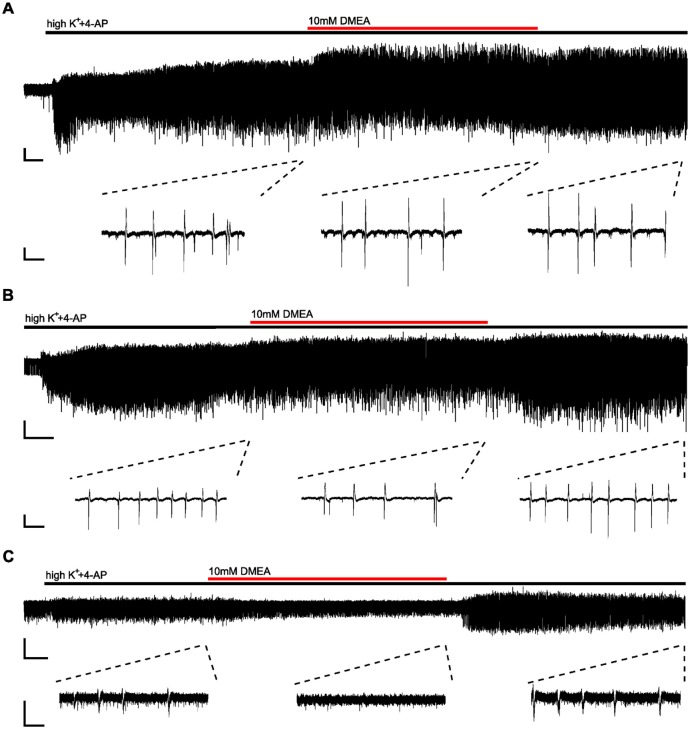
Effects of DMEA on epileptiform activity in human brain tissue ex vivo. Example traces displaying variability of DMEA effects on burst activity; full recordings (top) and excerpts (bottom) from the end of each period (baseline, DMEA and wash-out) demonstrate different effects of DMEA including a lack of response (A, patient 8), a partial block (B, patient 7) and a full block (C, patient 11). Scale bars: 0.2 mV, 3 min (full recordings), 1 s (excerpts).